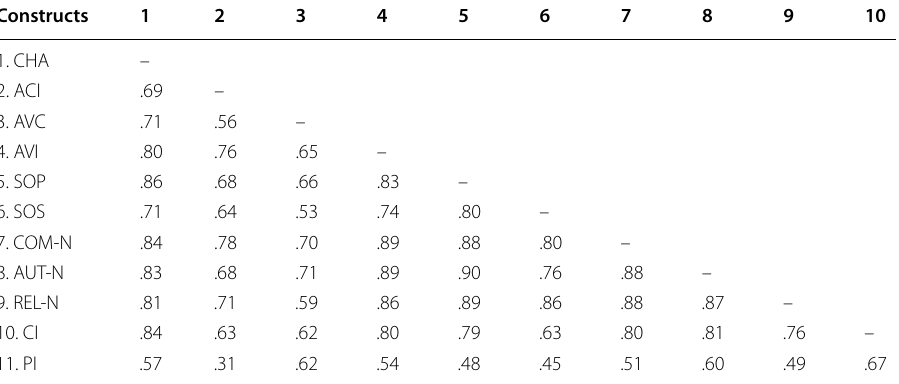
CHA Challenge, ACI Achievement, AVC Avatar customization, AVI Avatar identification, SOP Social presence, SOS Social support, COM-N Competence need fulfillment, AUT-N Autonomy need fulfillment, REL-N Relatedness need fulfillment, CI Intention to continuously use a VR fashion app, PI Intention to make in‑app purchases